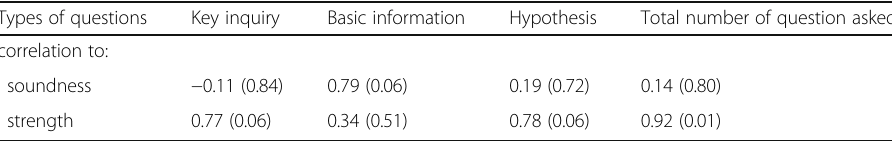
Table 6 Correlation coefficient of question types and total number of questions to soundness and strength of argument